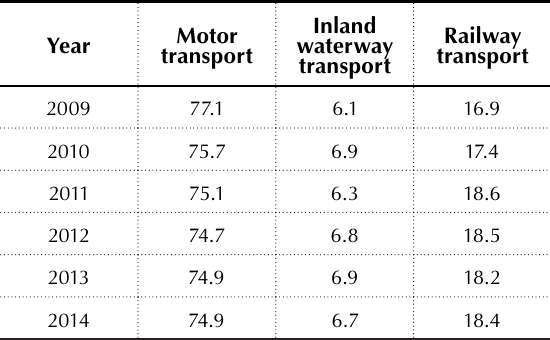
Table 3. Distribution of freight transport by type in the EU countries, % of the total transport flow in